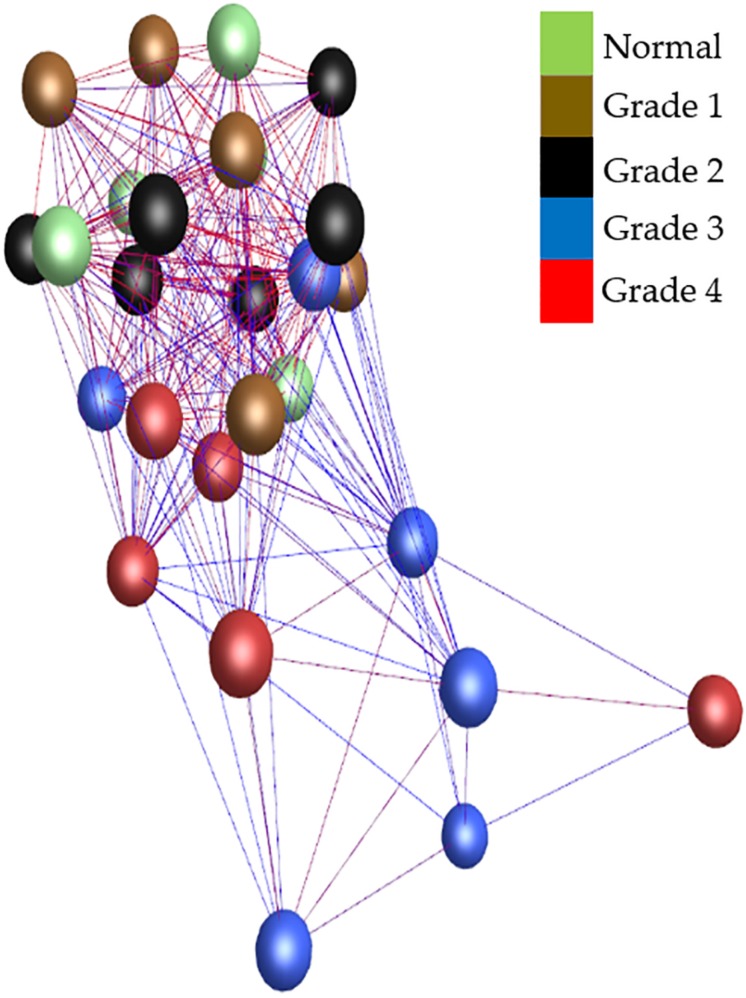
Sample-to-sample analysis using Graphia Pro 1.4. Each node represents a sample, colored by grade of disease. Normal samples are colored green, grade 1 brown, grade 2 black, grade 3 blue, and grade 4 red. Edge color represents degree of correlation (red being stronger and blue being weaker) above the assigned correlation coefficient cut off (r = 0.97). Outliers have been removed.